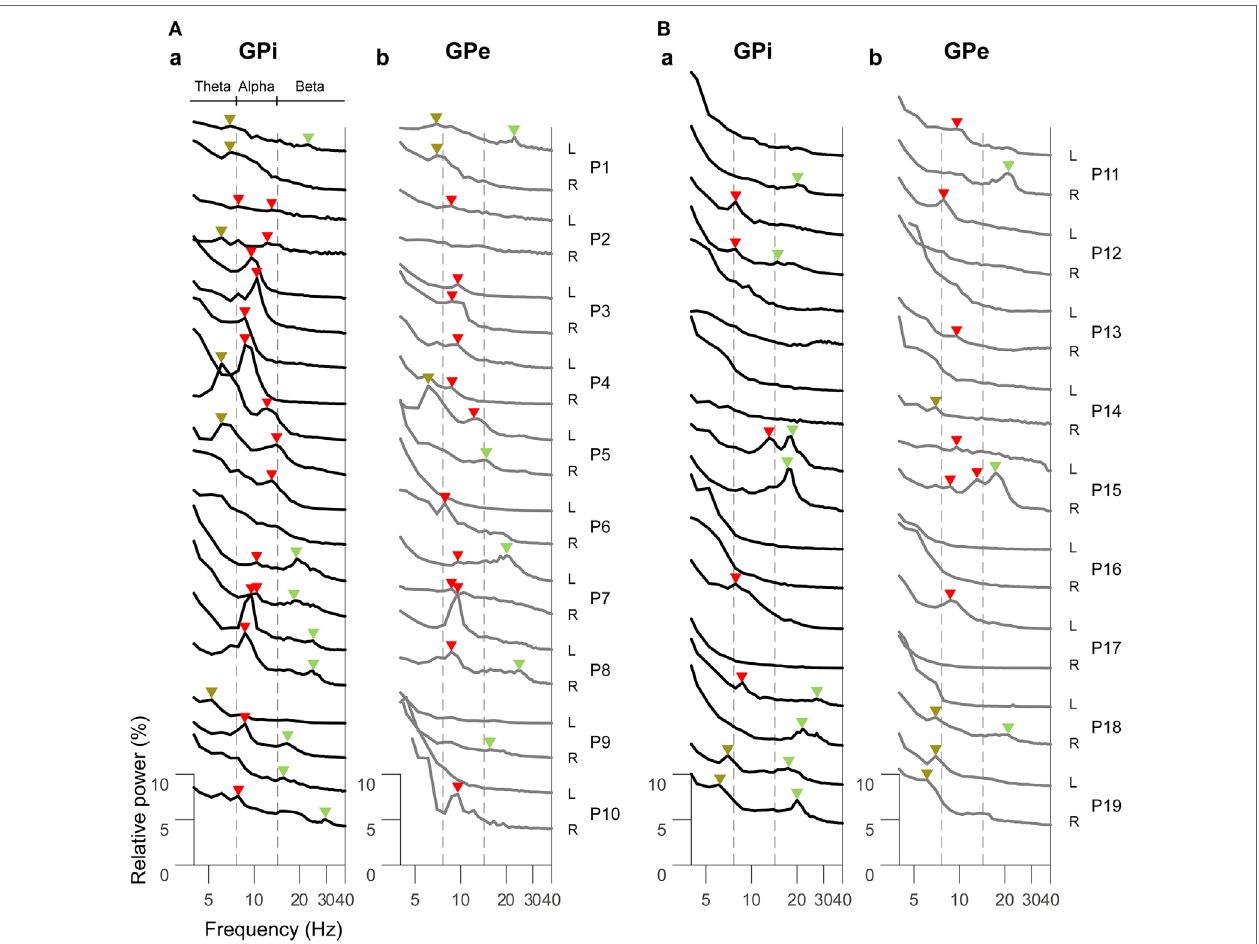
FigUre 1 | Resting-state power spectral profiles in the bilateral GPi and GPe in phasic (a) and tonic (B) patients. The black and gray solid lines represent the GPi (a) and GPe (b) power spectra over the theta (5–7 Hz), alpha (8–13 Hz), and beta (14–35 Hz) frequency bands, respectively. Patient numbers and the recorded hemispheres (L: left hemisphere and R: right hemisphere) are shown in the right of each power spectral profile. The brown, red, and green arrows shown above each power spectral profile represent the spectral peaks over the theta, alpha, and beta bands, respectively. There is no spectral peak in the delta (2–4 Hz) band. The vertical dotted gray lines show the boundaries of each frequency range (between theta and alpha, and between alpha and beta